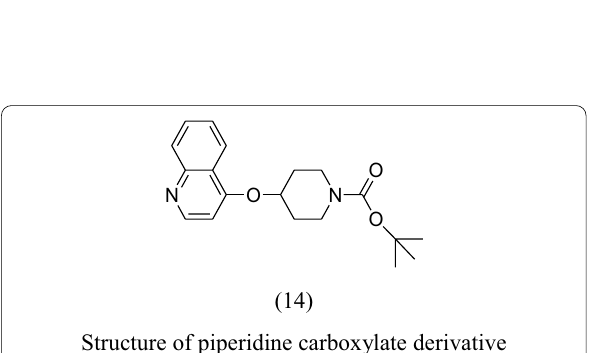
Fig. 20 Structure of piperidine carboxylate